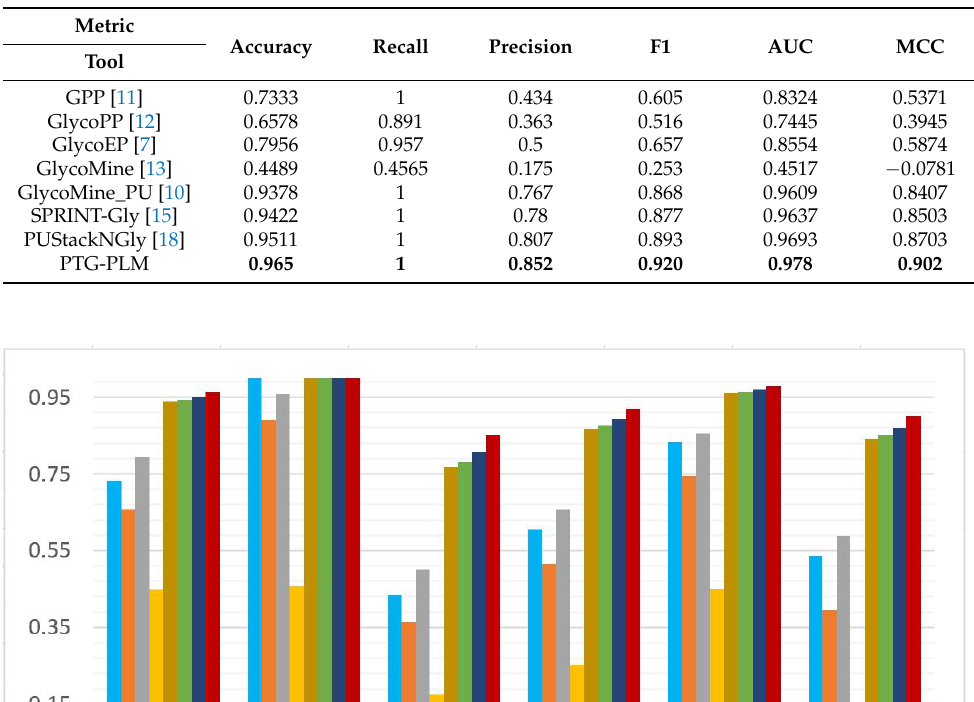
Table 9. Comparison of performance of PTG-PLM against the existing tool for Ngly site prediction.